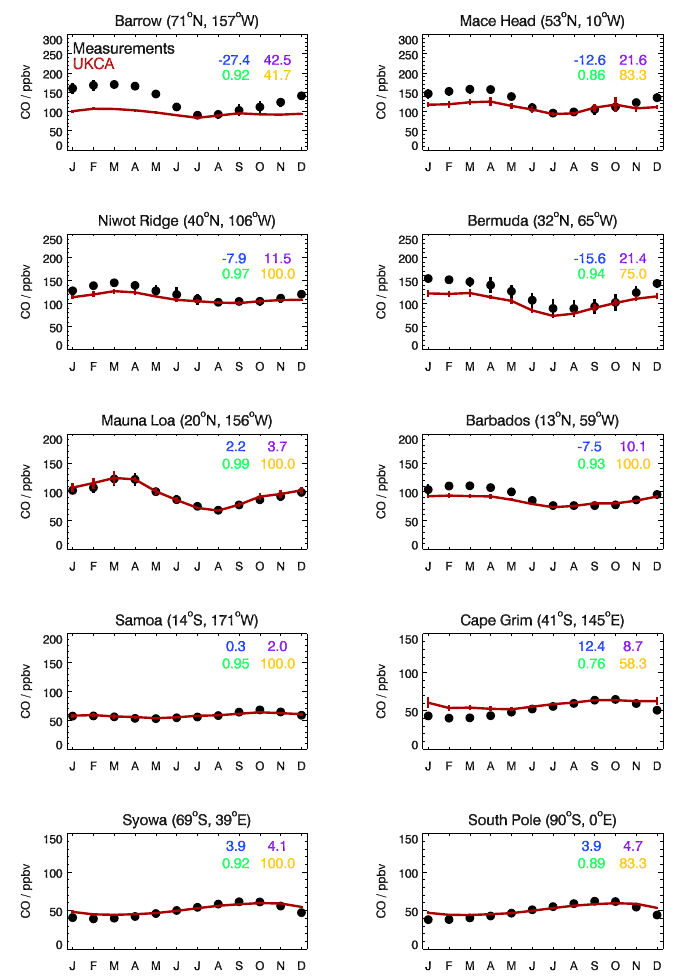
Fig. 16. Comparison between multi-annual monthly mean modelled surface CO concentrations with surface observations from the 1999–2006 time period. The surface sites include Barrow (71 ◦ N, 157 ◦ W), Mace Head (53 ◦ N, 10 ◦ W), Niwot Ridge (40 ◦ N, 106 ◦ W), Bermuda (32 ◦ N, 65 ◦ W), Mauna Loa (20 ◦ N, 156 ◦ W), Barbados (13 ◦ N, 59 ◦ W), Samoa (14 ◦ S, 171 ◦ W), Cape Grim (41 ◦ S, 145 ◦ E), Syowa (69 ◦ S, 39 ◦ E), and the South Pole (90 ◦ S, 0 ◦ E). The relative annual mean bias (in %), the root mean square error (in ppbv), the correlation coefficient, and the model score (the percentage of months where the modelled and observed monthly mean concentrations are within 20% of each other; in %) are shown for each location in blue, purple, green, and orange, respectively. 88